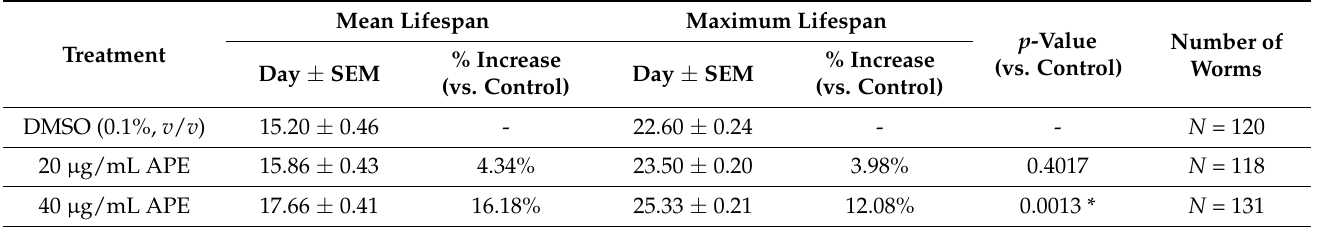
Table 2. Results and statistical analyses of the lifespan of C. elegans treated with APE.